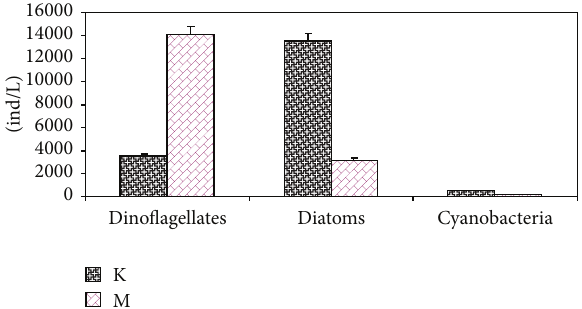
Figure 2: Average abundance of planktonic microalgae in pros- pected stations, K: Skhira (disturbed station), M: Mahdia (control